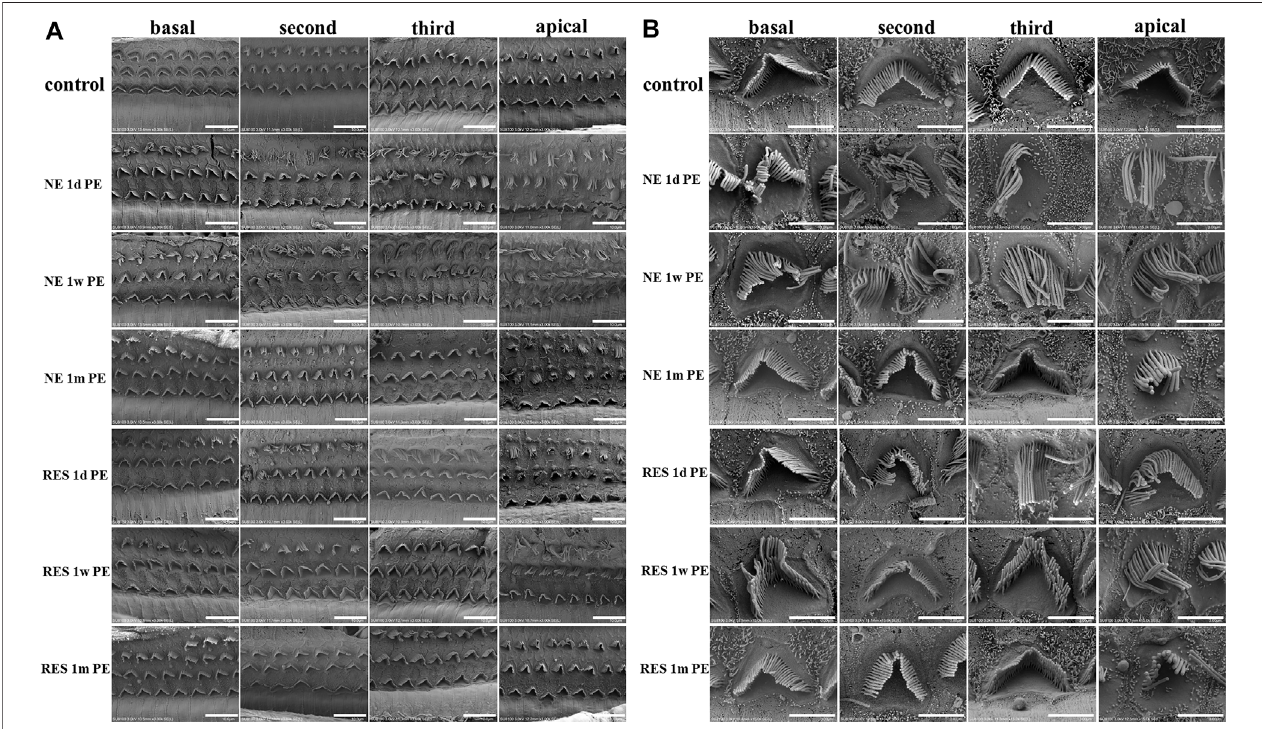
FIGURE 3 | Noise induced changes of the morphology of basilar membrane after noise exposure. In (A) , scale bar = 10 µm. In (B) , scale bar = 3 µm.